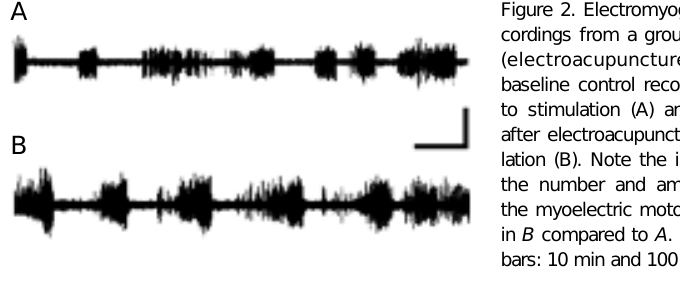
Table 2. Change in root mean square of the myoelectric activity recorded in the proximal 1/3 of the small intestine at four different locations for each of the three experimental groups (electroacupuncture, sham electroacupuncture and immobilized) compared to the baseline condition (control